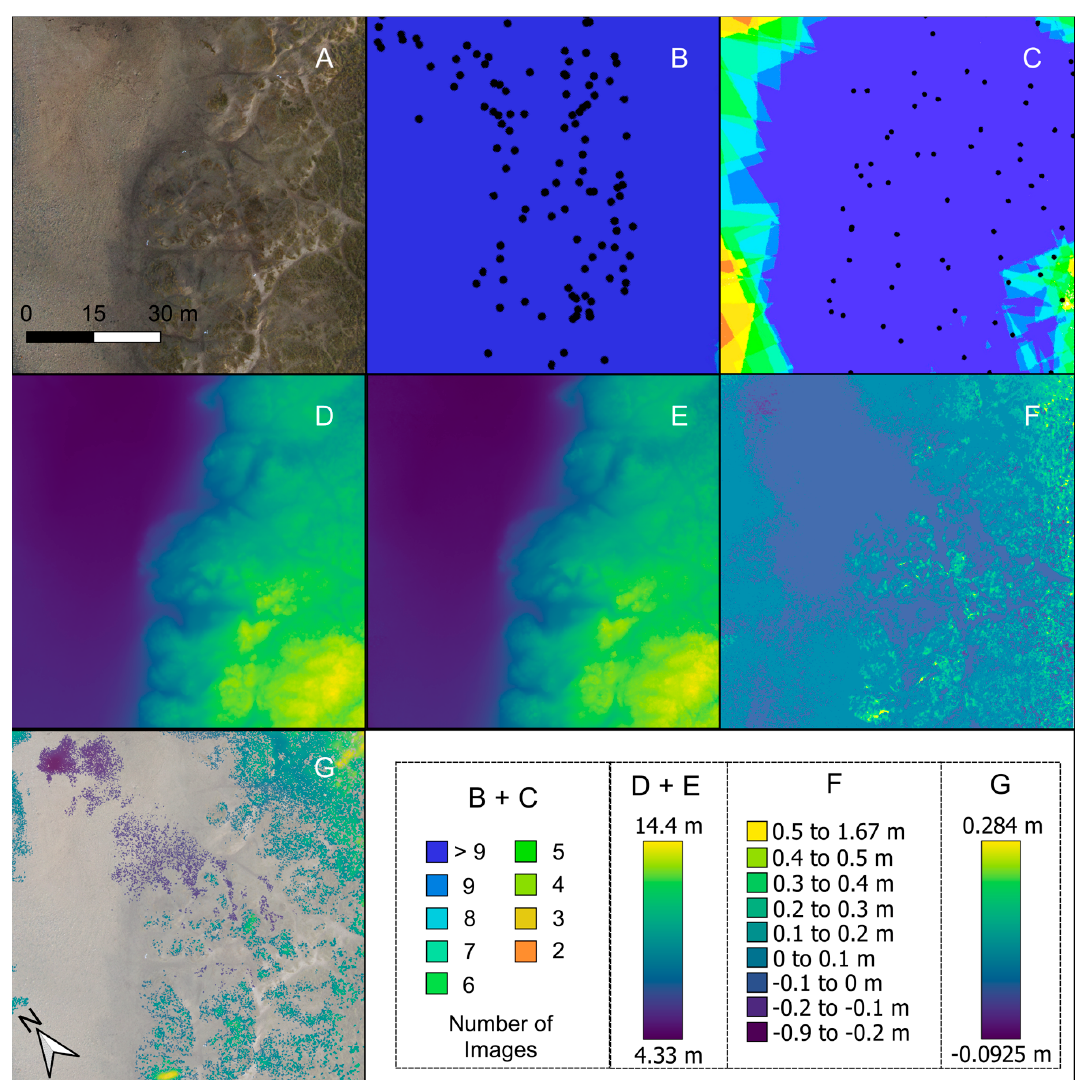
Figure 6. Comparisons between KAP survey 6 and the drone survey ( A ) An orthomosaic created from images captured in KAP survey 6; ( B ) Image overlap for the KAP survey (taken from Photoscan report); ( C ) Image overlap for the drone survey (taken from Photoscan report). Black dots show estimated camera positions; ( D ) Digital elevation model (DEM) for the KAP survey; ( E ) DEM for the drone survey; ( F ) A DEM of difference between the KAP and drone DEMs; ( G ) Rasterised representation (spatial resolution of 0.1 m for display purposes) of significant results from M3C2-PM change analysis between point clouds created with data from KAP and drone surveys (overlaid on orthomosaic (at 50% transparency) from panel ( A ). Non-significant change points are absent from ( G